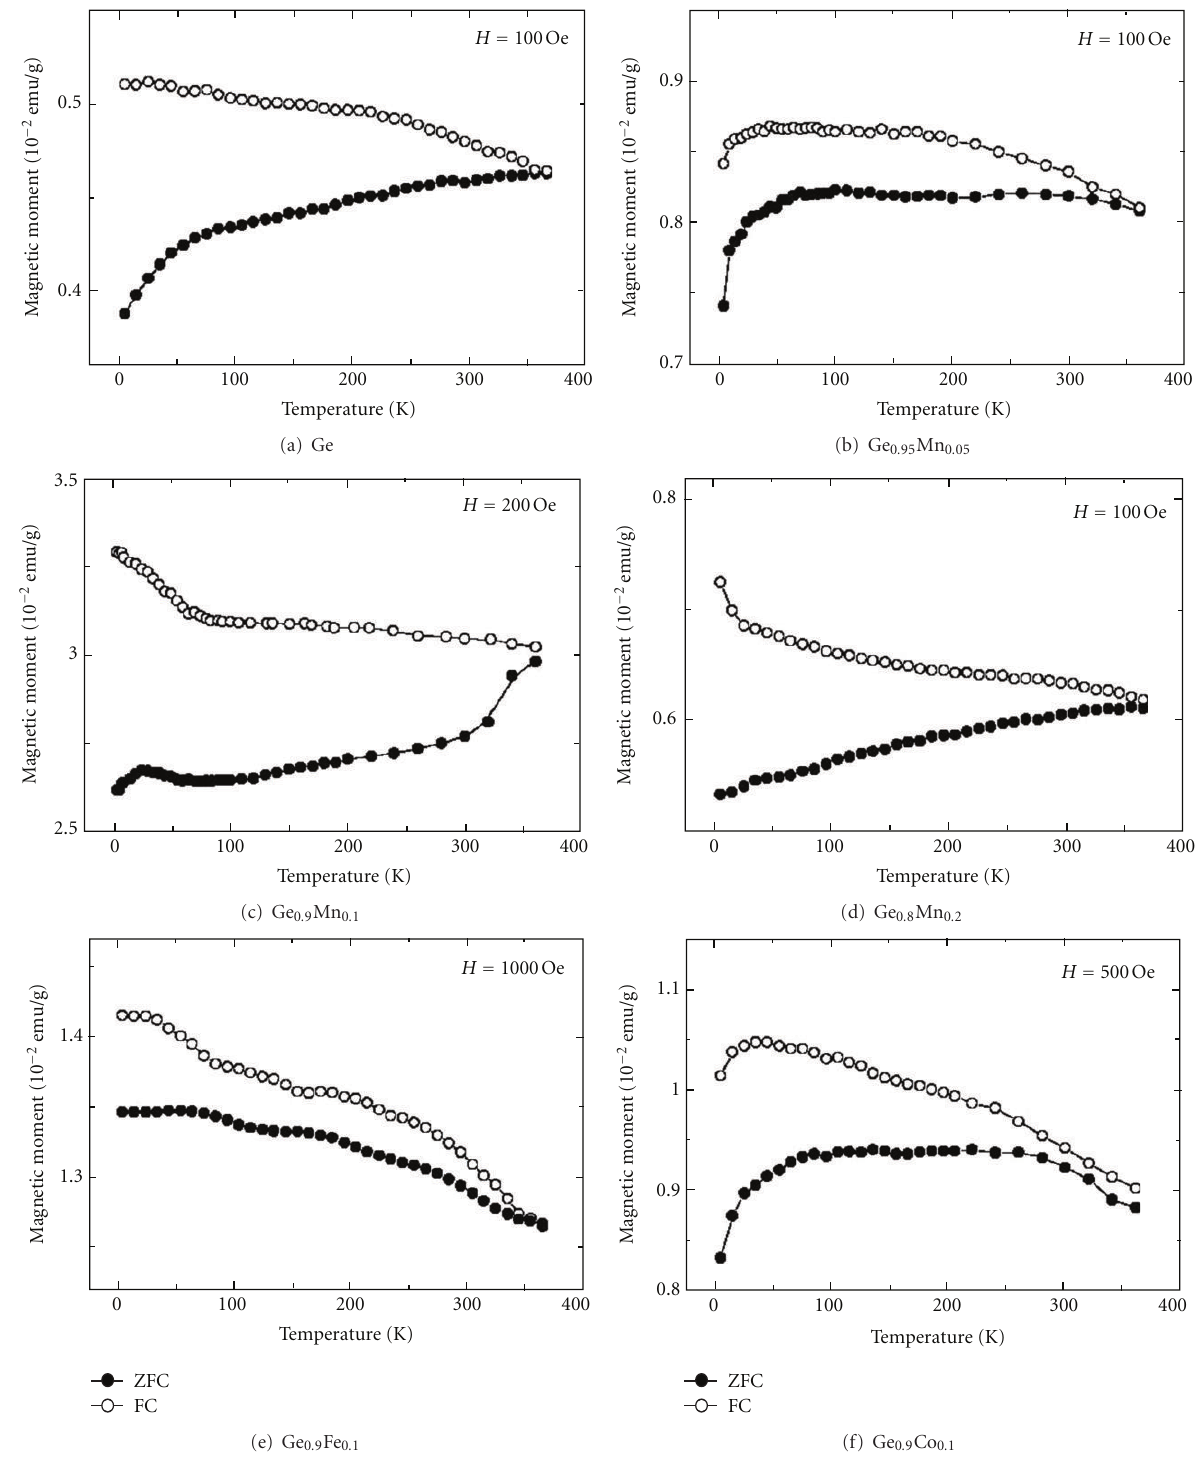
Figure 21: ZFC and FC curves of the (a) Ge, (b) Ge 0 . 95 Mn 0 . 05 , (c) Ge 0 . 9 Mn 0 . 1 , (d) Ge 0 . 8 Mn 0 . 2 , (e) Ge 0 . 9 Fe 0 . 1 , and (f) Ge 0 . 9 Co 0 . 1 NWs, under a magnetic field at H = 100–1000 Oe, indicating that the ferromagnetism persists to 350 K. Reproduced from the supporting information